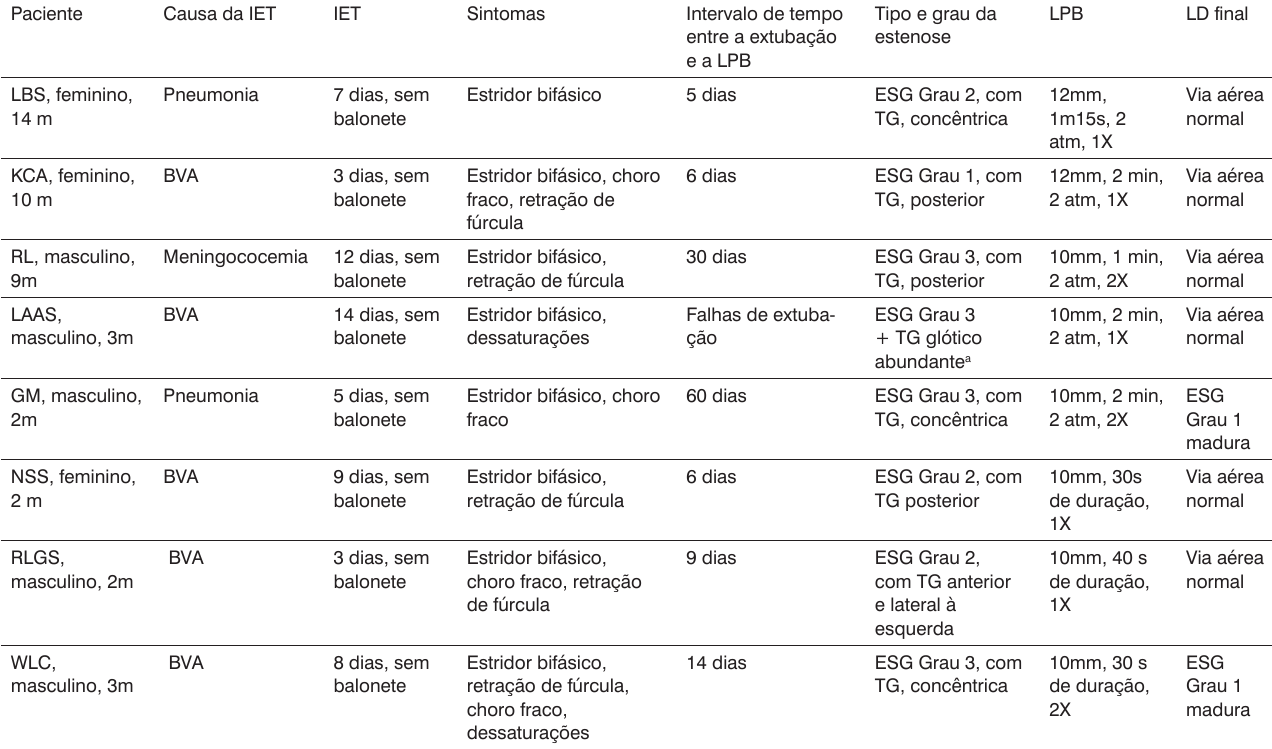
BVA: Bronquiolite Viral Aguda. IET: intubação endotraqueal. LD: laringoscopia direta. LPB: tamanho do balão de dilatação (diâmetro externo do balone- te), duração da dilatação (balonete inflado, obstruindo completamente via aérea do paciente), pressão do balão, número de dilatações realizadas. TG: tecido de granulação. ESG: estenose subglótica. a : Paciente necessitou de traqueostomia, pois o tecido de granulação (TG) glótico persistiu obstrutivo por 2 semanas após a dilatação da subglote. Após este período, o TG regrediu totalmente e o paciente foi decanulado. A estenose subglótica regrediu totalmente após a LPB.